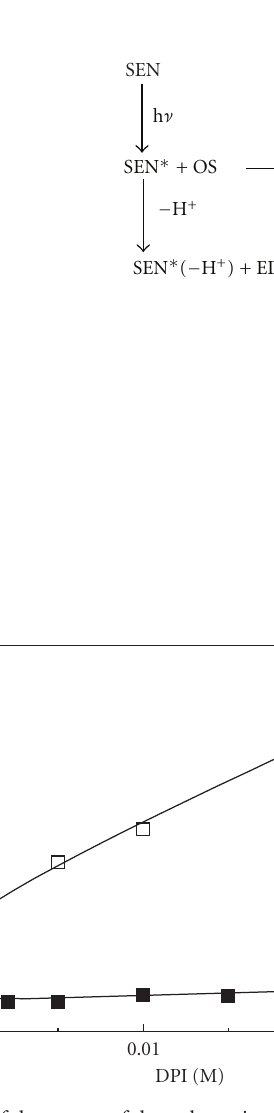
Figure 6: Plot of the square of the polymerization rate ( (cid:2) ) and the radical yield ( (cid:3) ) measured as the long-lived absorption at 425 nm by laser flash photolysis as a function of DPI concentration relative to the values in the absence of DPI. TEOA concentration is 0.027